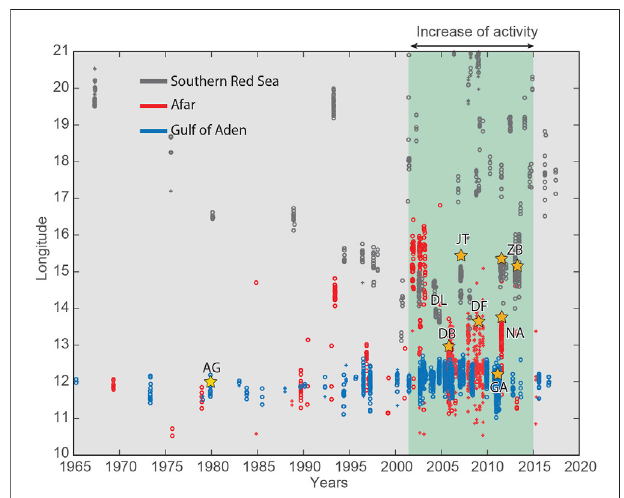
FIGURE 10 | Increase of swarm and volcanic activity observed from 2003to2013in theSAGAregion,preceded andfollowedbylower rates of swarm activity and the absence of volcanic eruptions. Yellow stars are eruptions; AG: Asal Ghoubbet; DL: Dallol; DB: Dabbahu; JT: Jebel at Tair; DF: Alu Dala fi lla; GA: Gulf of Aden; NA: Nabro; ZB: Zubair